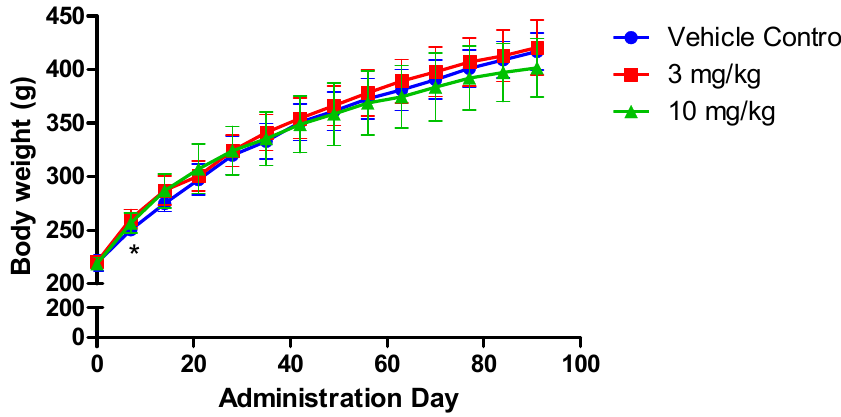
Figure 1. Mean body weight of rats treated with flurochloridone (FLC) for ninety days. * A significant difference at p < 0.05 level compared with the control.